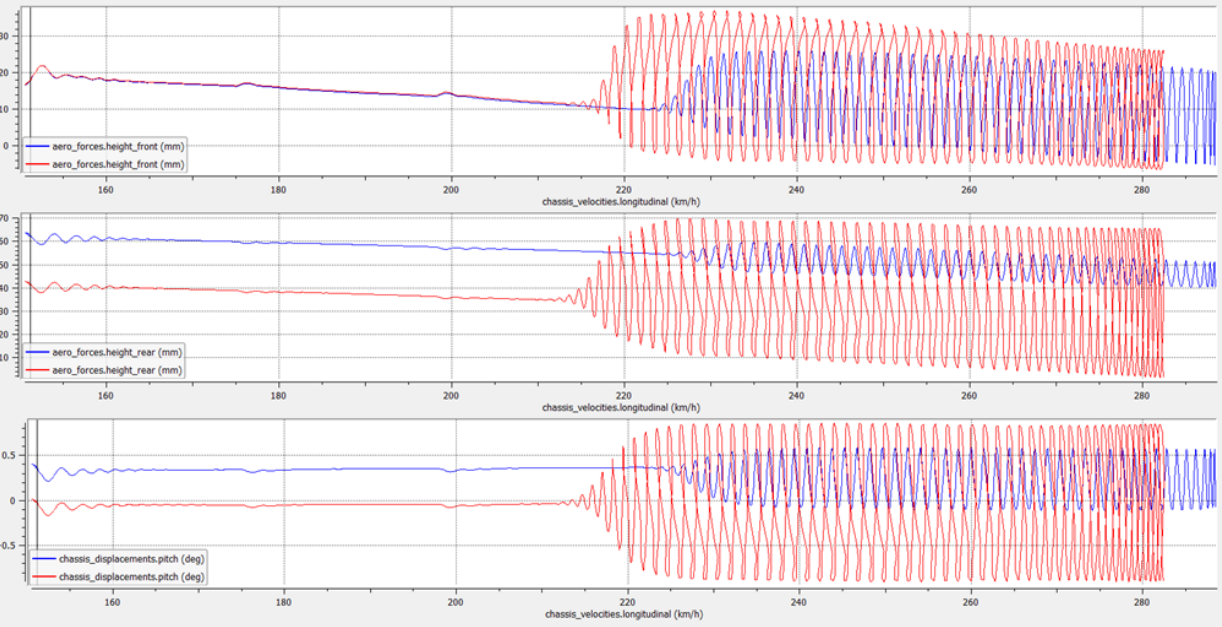
Figure 25. Rear ride height +20 mm (blue): bouncing is significantly reduced at the rear axle and at the front end as well. In this plot FRH ( top ), RRH ( center ), and pitch variation ( bottom ) are shown.